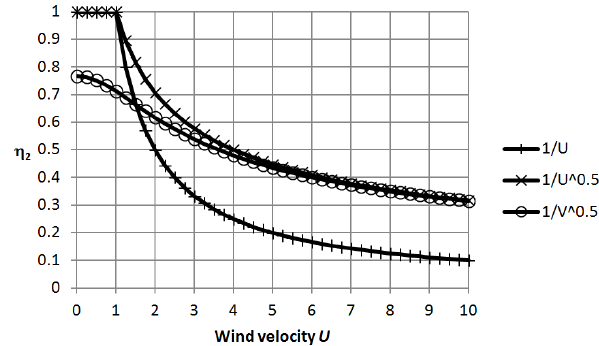
Figure 1. Sticking efficiency factor η 2 , when V t = 1.7ms − 1